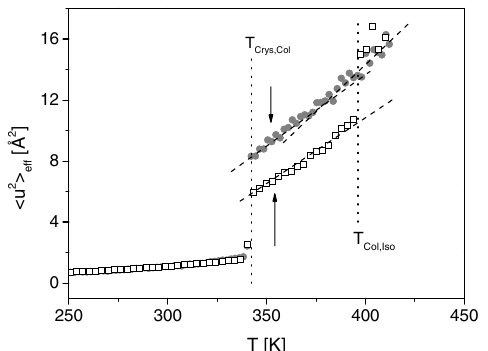
Figure 6. Temperature dependence of the effective mean square displacement < u 2 > eff for HAT5 (open squares) and HAT6 (filled circles) at higher temperatures in the hexagonal ordered liquid crystalline phase. The dotted lines correspond to the phase transition temperatures of HAT5 estimated by DSC. The dashed lines are guides to the